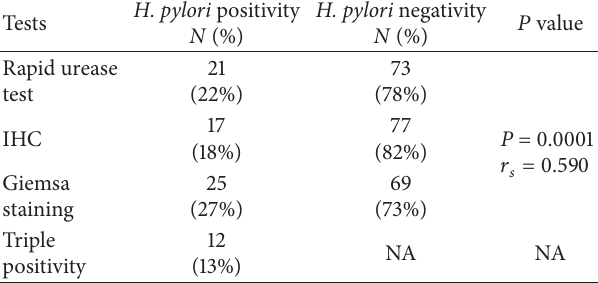
Table 2: Detection of H. pylori presence with different